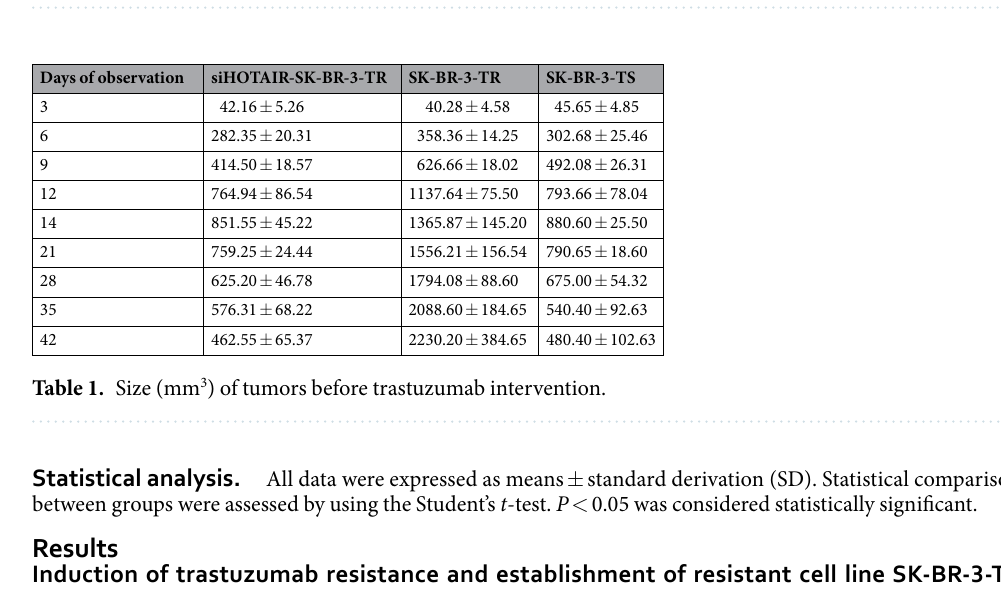
Figure 4. Cell cycle assessments of breast cancer cells treated with trastuzumab and following HOTAIR